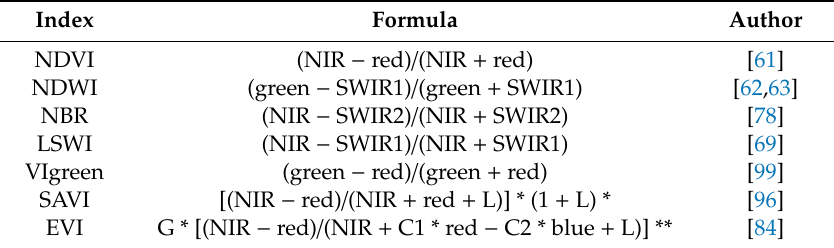
Table 3. Selected vegetation